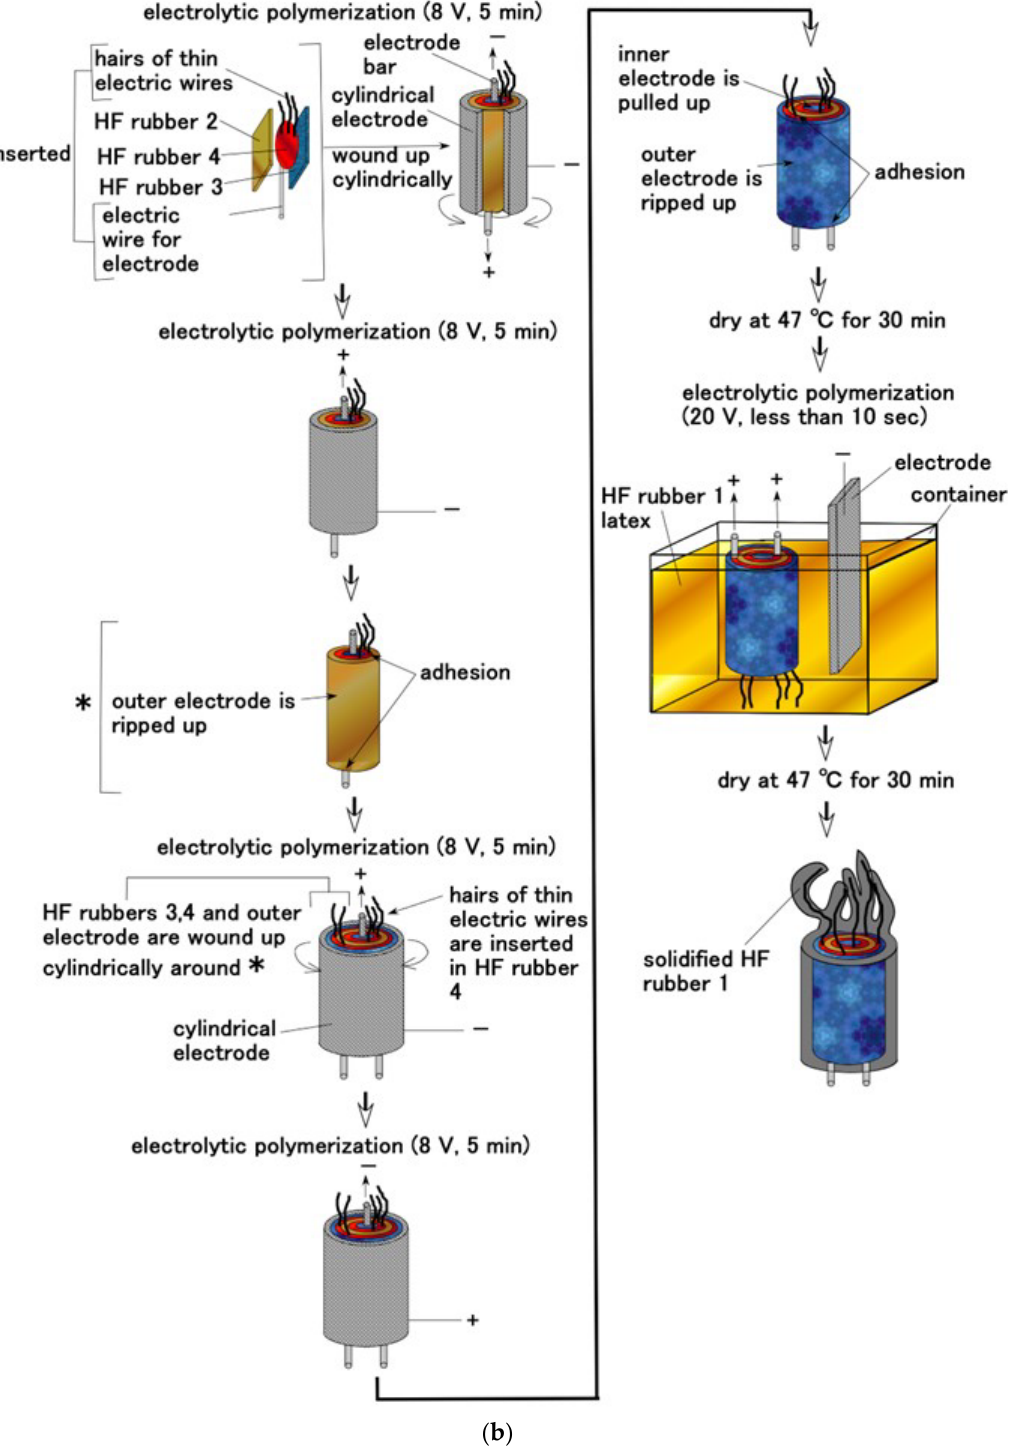
Figure 3. Schematic diagram showing the production and fabrication procedures of HF rubber re- ceptors: ( a ) free nerve endings and ( b ) Pacinian corpuscles. receptors: ( a ) free nerve endings and ( b ) Pacinian